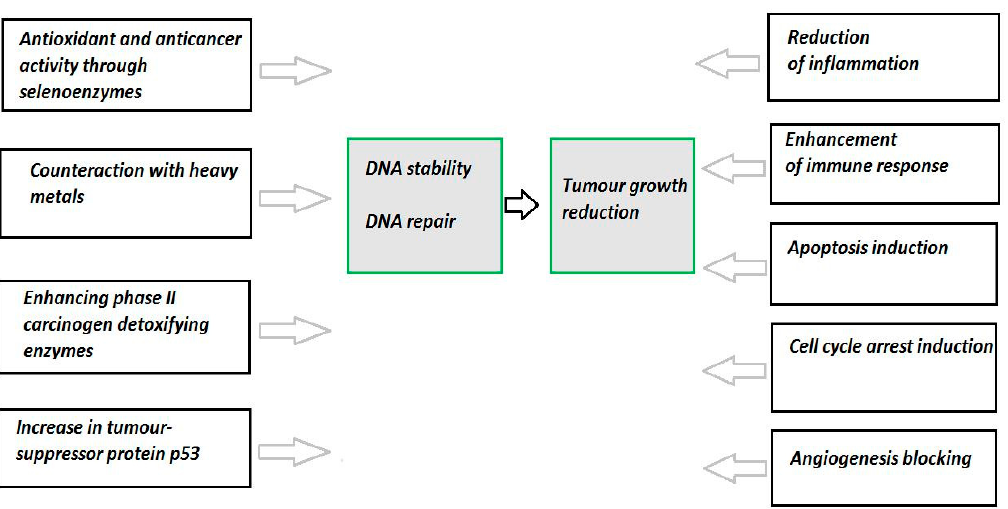
Figure 2. Anticancer effect of selenium may be asserted through various events and pathways in the cell. Data from studies [29,52,57,67–69].